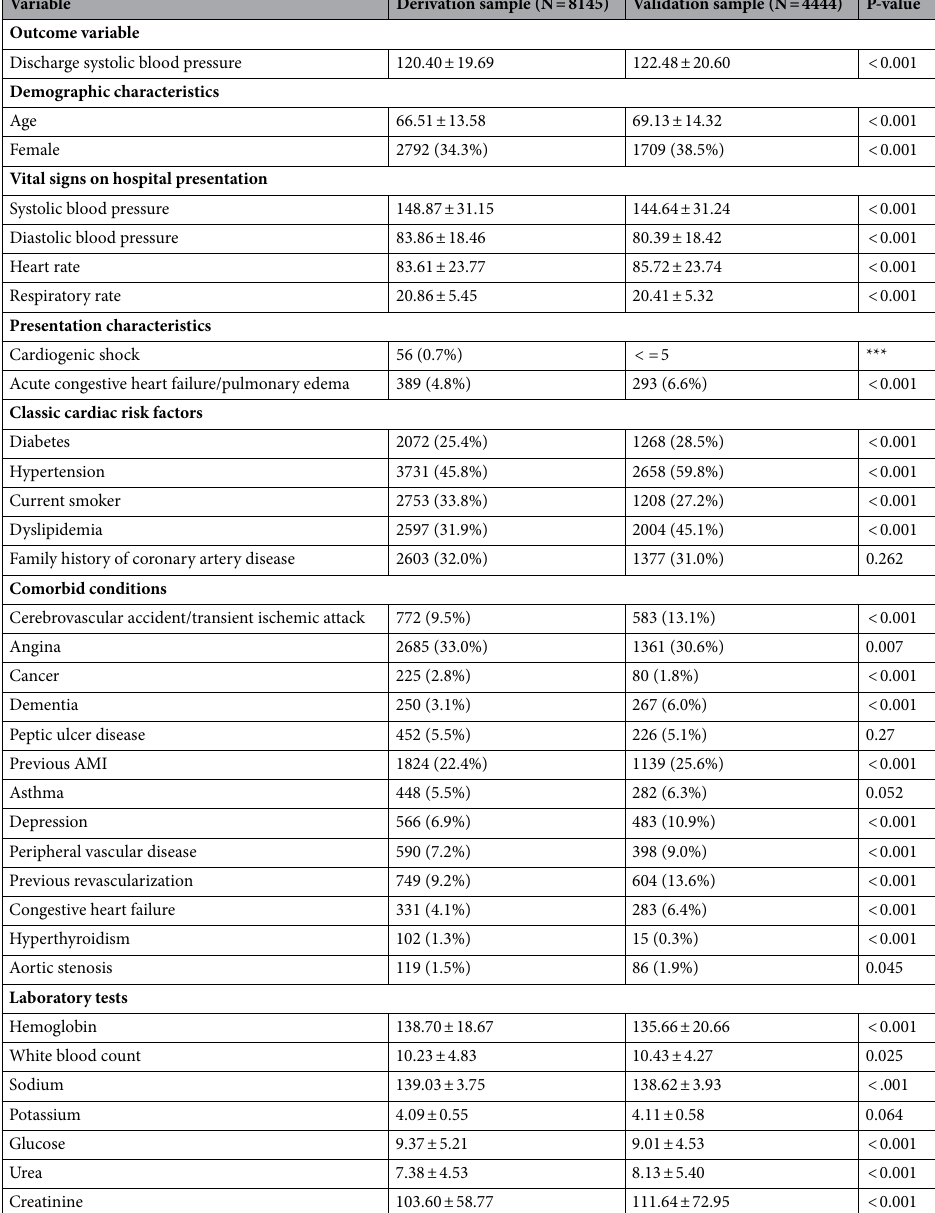
Table 1. Baseline characteristics of patients in the AMI derivation and validation samples. Continuous variables are reported as mean ± standard deviation, while binary variables are reported as N (%). ***Suppressed due to small sample